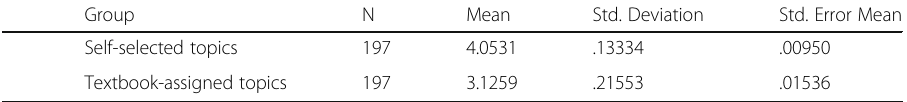
Table 17 The Mean Values of the Learner ’ s Perception of the Textbook-Assigned Topics and Self- Selected Topics Regarding the Topic Interest, Familiarity, Importance, and